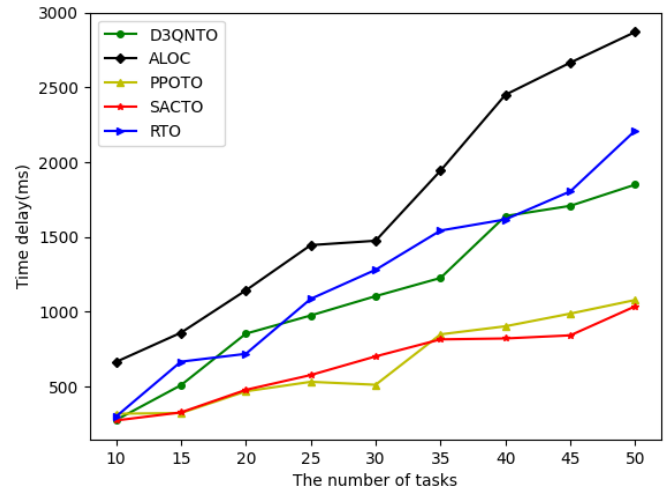
Figure 4. The Effect of Number of Tasks on Delay.